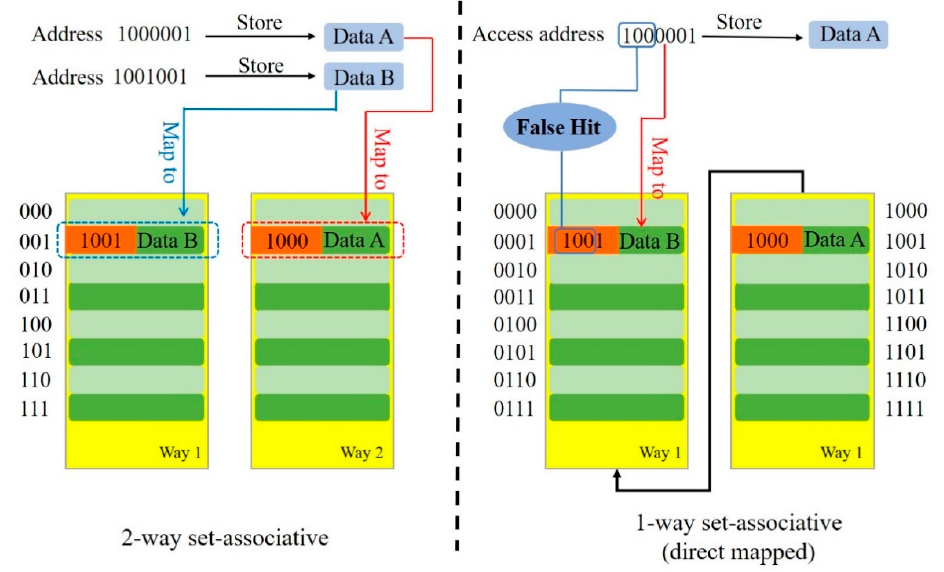
Figure 6. False hit caused by associativity decrease.